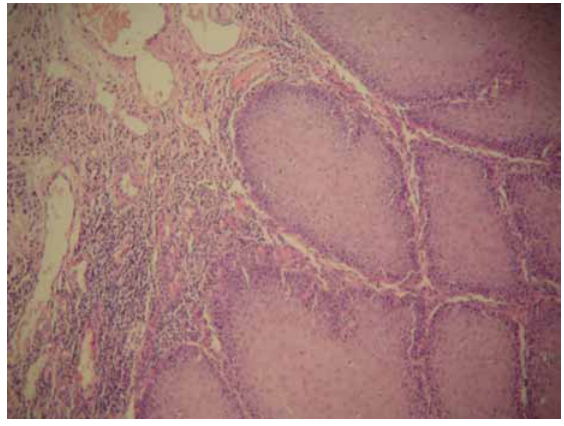
Figure 6. Thick, blunt indentations into the stroma, consisting of a well differentiated stratified epithelium with no atypical cells. Hematoxylin-eosin staining (HE). Magnification